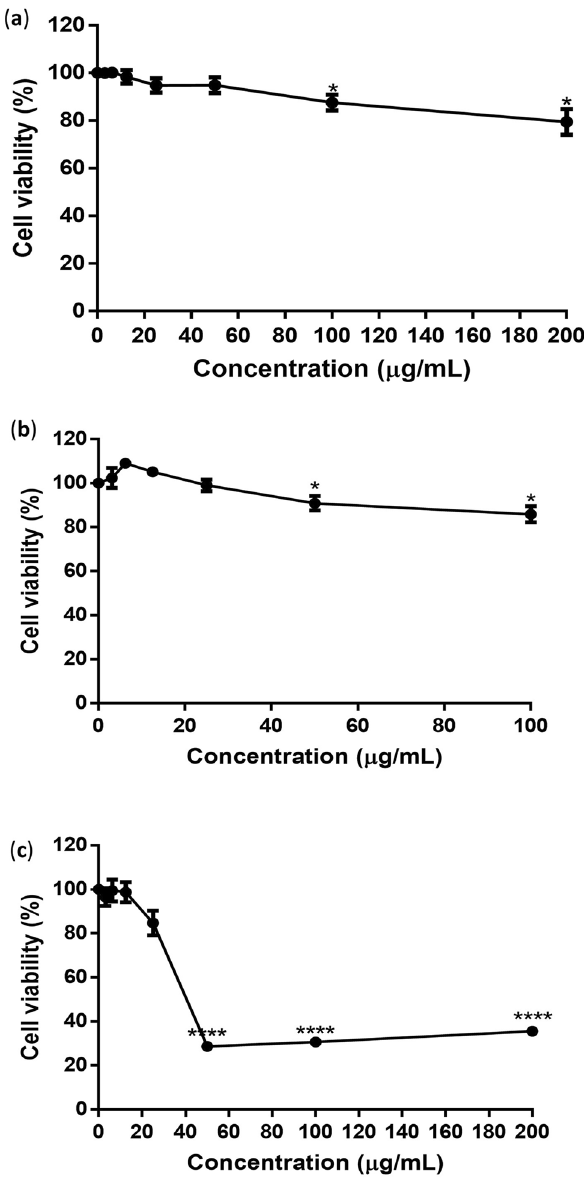
Figure 1. Cytotoxic effects of ( a ) silymarin, ( b ) baicalein, and ( c ) baicalin in Vero cells. Flavonoids were serially diluted in DMEM supplemented with 2% FBS, and Vero cells were treated with the diluted flavonoids for up to 48 h. The cytotoxicity of each flavonoid was determined by MTS assay using a microplate reader to measure the absorbance at 490 nm. Data presented as mean ± SEM. Error bars indicate the range of values obtained from three independent experiments. *P < 0.05, **** P < 0.0001 indicates a significant difference compared to the negative control analysed by the